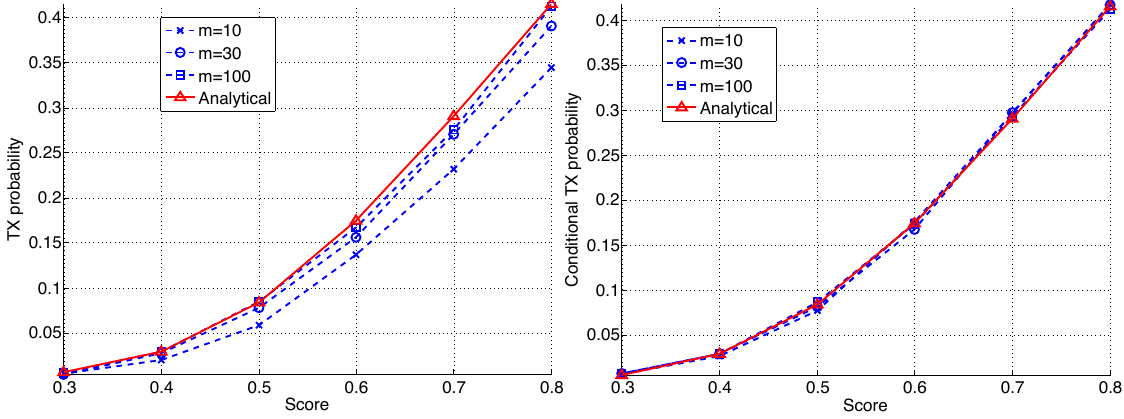
Figure 12. Probability of a successful transmission as a function of the